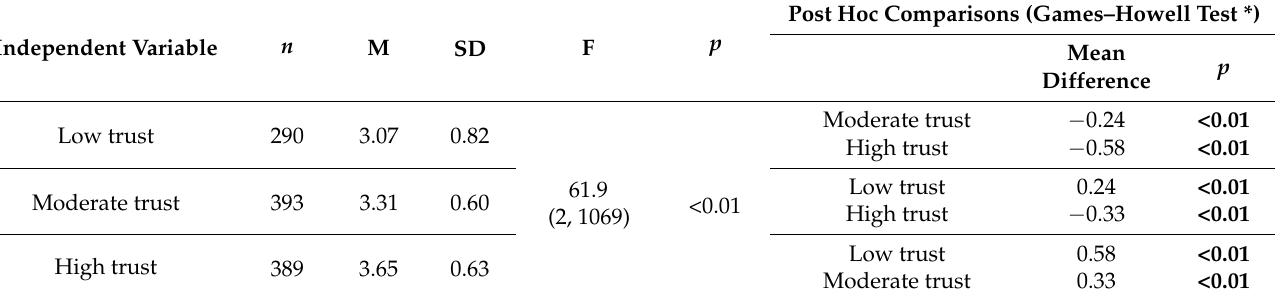
Table 4. Results of one-way ANOVA on the recommended behavior index (continuous variable) for groups differing in trust in